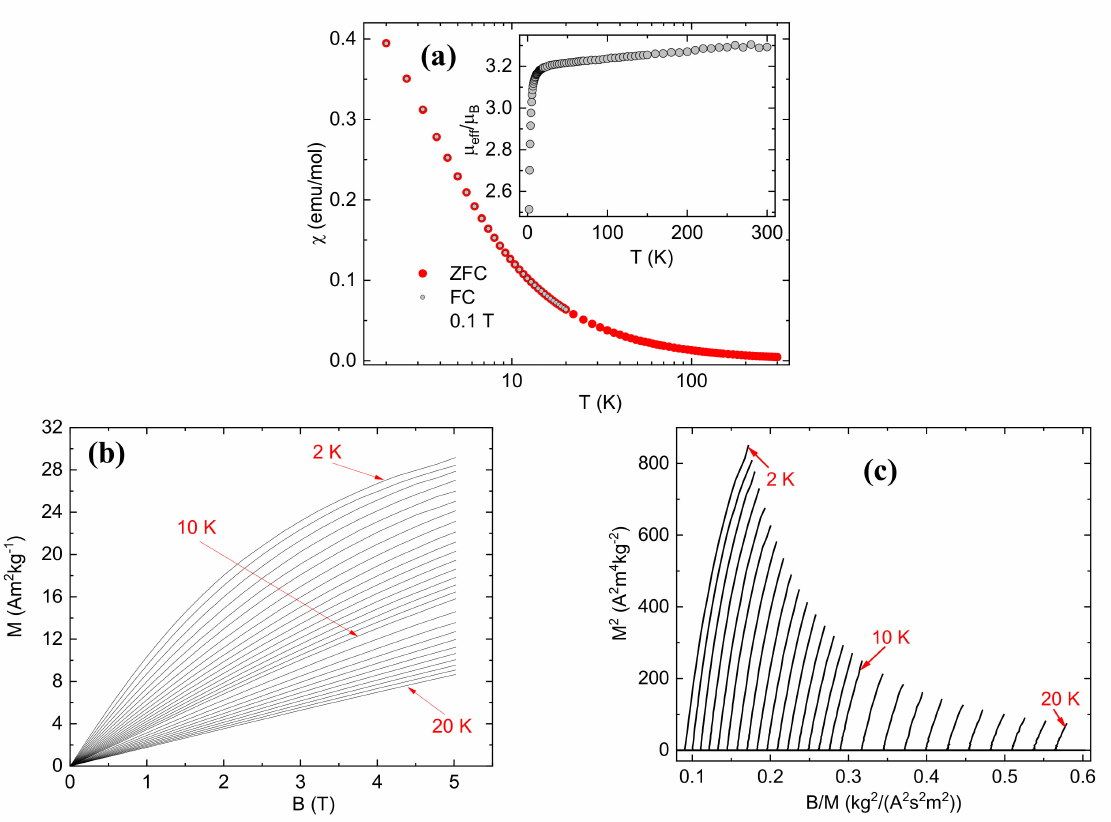
Figure 5. ( a ) Temperature dependence of the magnetic susceptibility measured in ZFC and FC regimes of NiHmal. Inset: Temperature dependence of the effective magnetic moment of NiHmal; ( b ) Isothermal magnetization curves of NiHmal powder sample at constant temperatures with temperature steps ∆ T = 0.5 K and 1 K in the intervals 2–10 and 11–20 K, respectively; ( c ) Arrott plot for the NiHmal powder